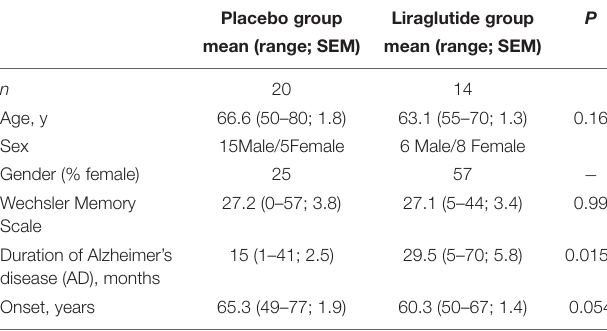
TABLE 2 | Demographic and baseline characteristics for completers at